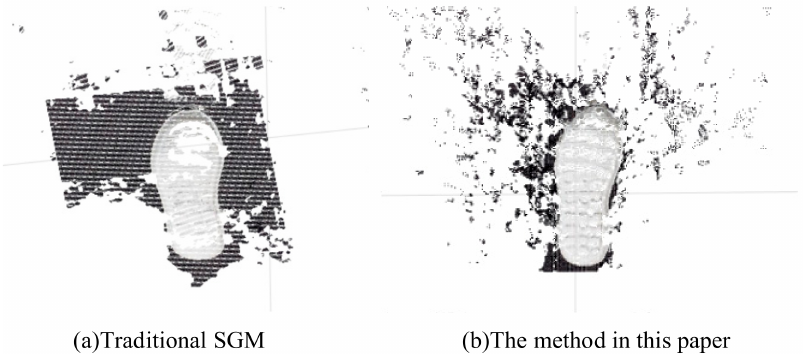
Figure 9. 3D reconstructed point cloud image of a shoe sole.